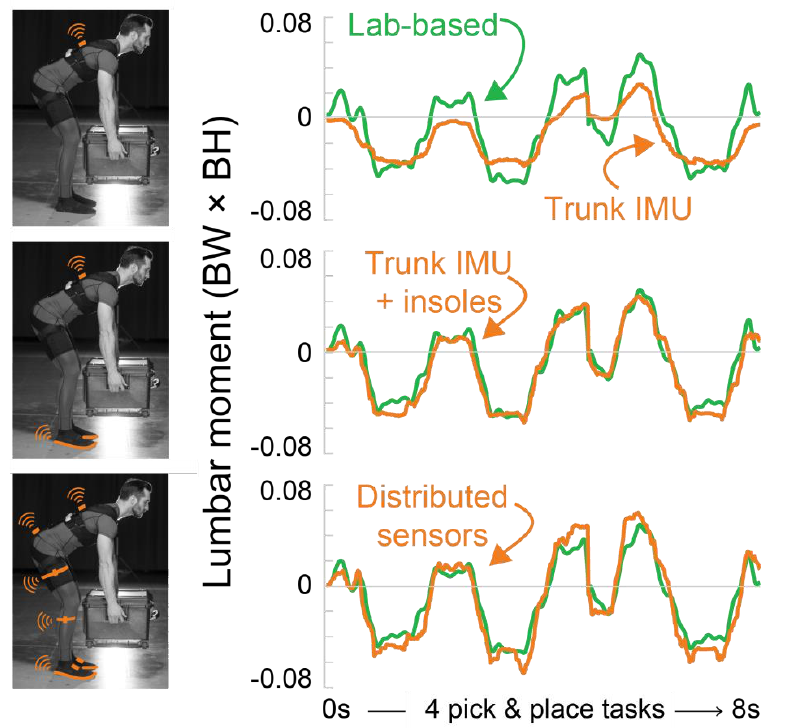
Figure A3. Representative example of lumbar lateral bending moment estimates based on different wearable sensor combinations. Shown are the lab-based (green) and algorithm-estimated (orange) lateral bending moments for three different sensor combinations. Depicted is a subset of the hundreds of manual material handling tasks performed for an example participant; 4 pick and place task cycles with a 5 kg box shown. These results were similar to those observed when estimating the lumbar extension moment (Figure 8): the single IMU wearable did not well estimate the higher magnitude lateral bending moments, but combining a pressure insole with at least one IMU improved these estimates. All the algorithms here were developed with idealized wearable sensor signals and the target was lumbar lateral bending moment. BW × BH = body weight × body height.